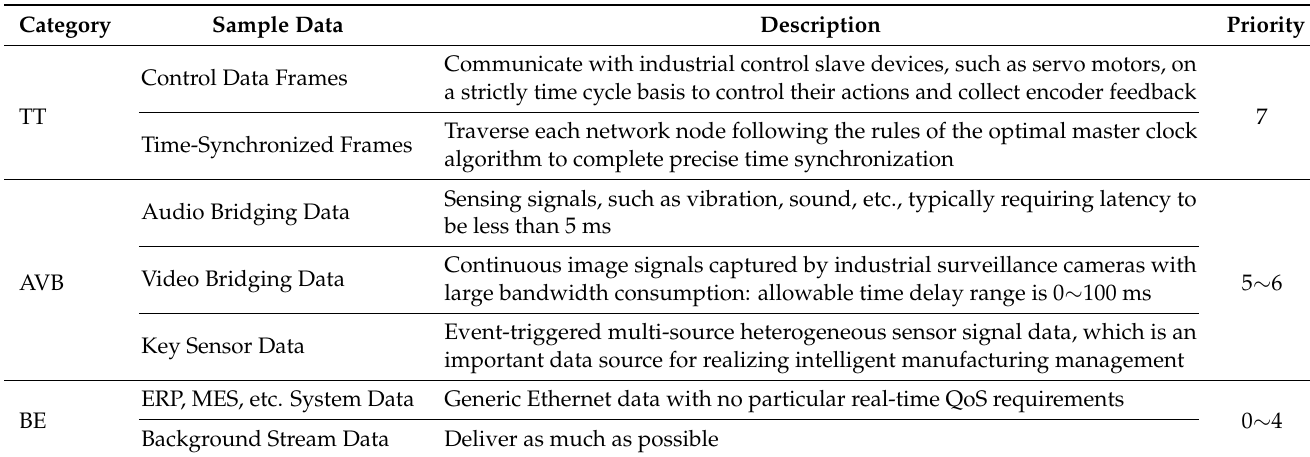
Table 1. TSN data